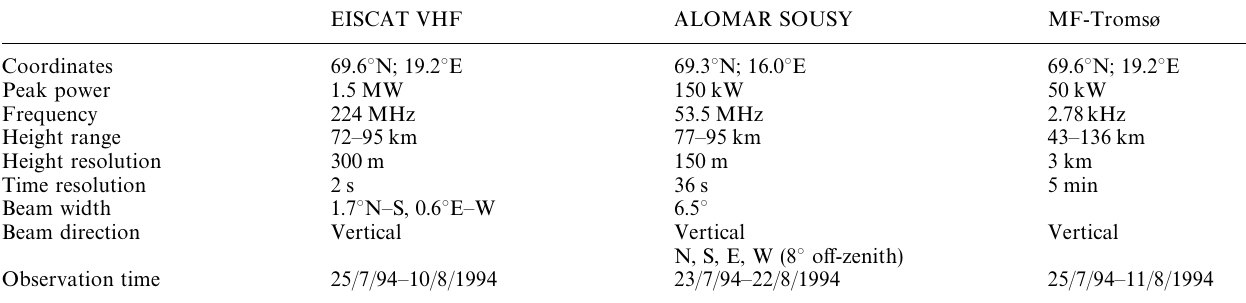
Table 1. Technical parameters of the radar systems used in summer